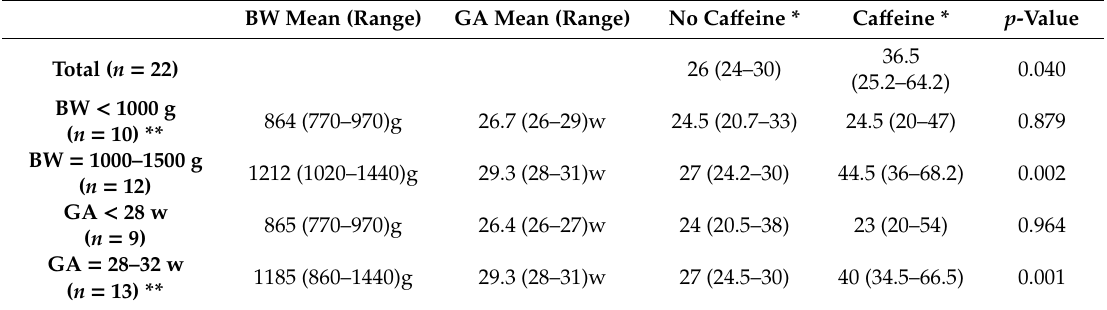
Table 2. Distribution of the half gastric emptying time (MIN) in the study neonates according to their ca ff eine intake status and the corresponding p